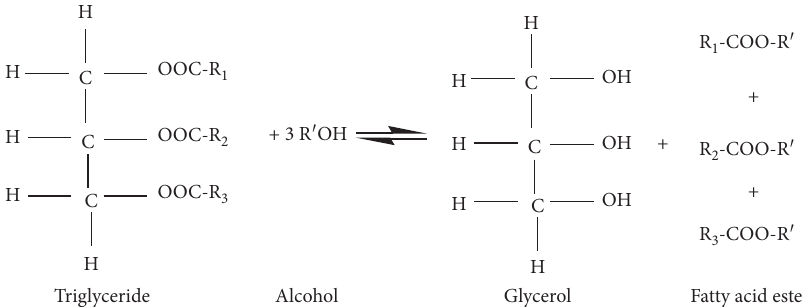
Figure 1: Transesterification reaction for